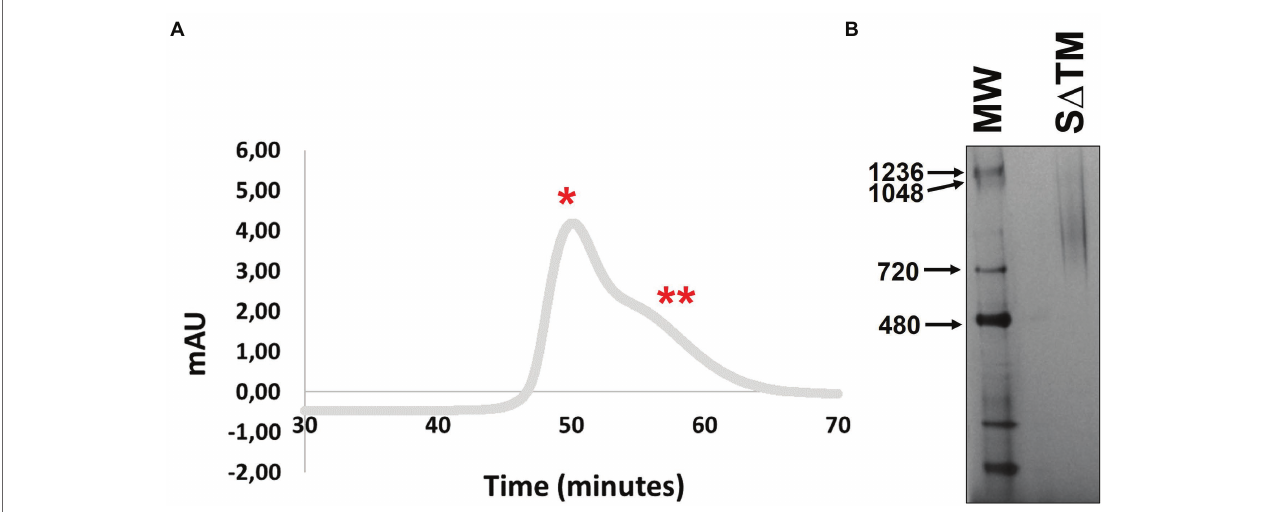
FIGURE 2 | Purification of SARS-CoV-2 S ∆ TM from plants. (A) Gel filtration of affinity-captured antigen using a Superdex 200 HiLoad 16/600 column. The two most prominent peaks are indicated by * and **, respectively. (B) Coomassie-stained BN-PAGE gel containing purified S ∆